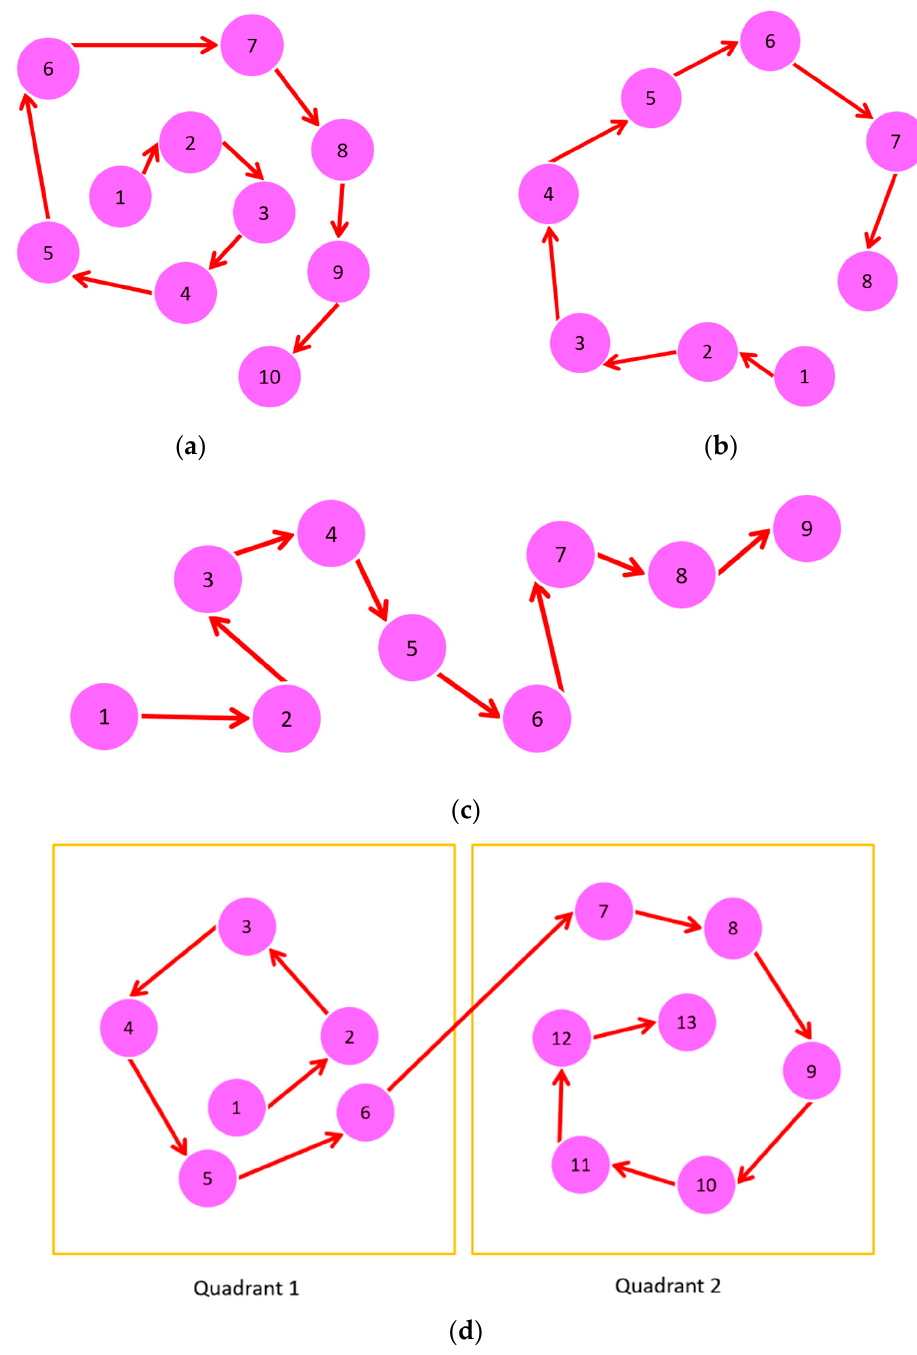
Figure 4. Representative examples of various kinds of scanpath in a visual search task. ( a ) Spiral; ( b ) Circular; ( c ) Linear; ( d ) Quadrants.